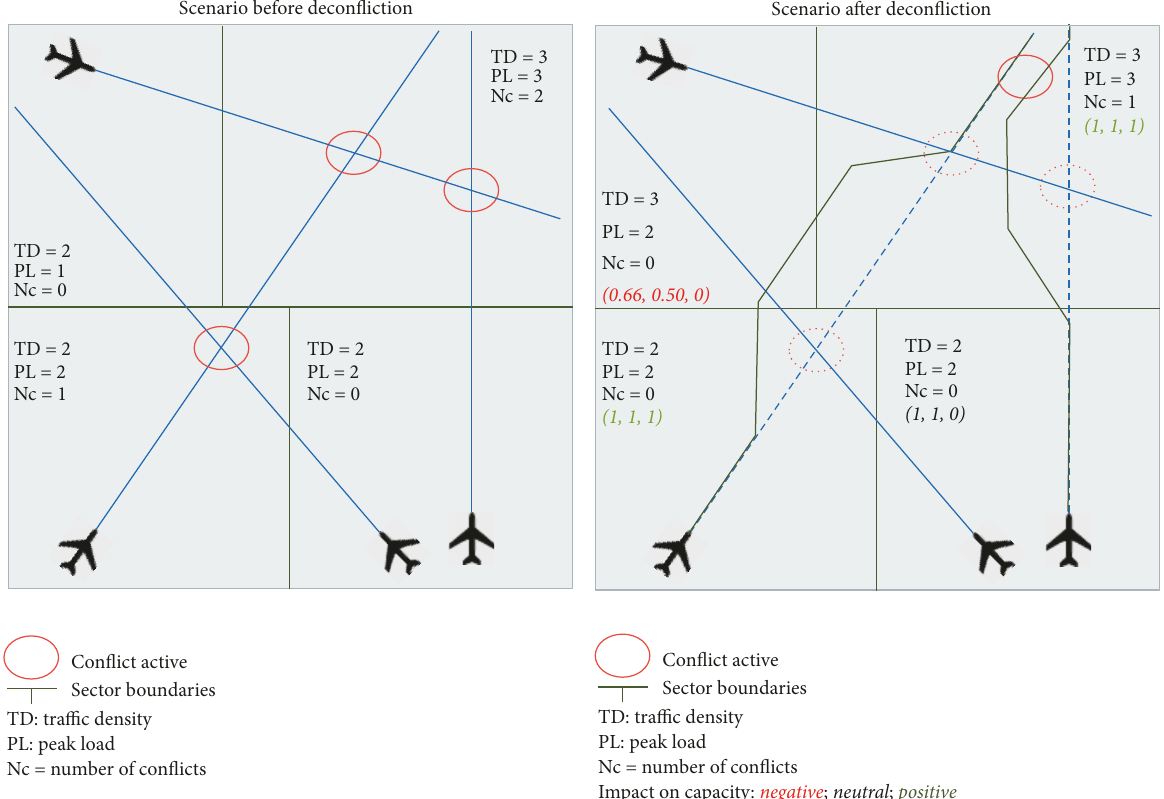
Figure 1: Notional illustration of the application of the impact on capacity metric. Dotted circle means “conflict solved.” (3) ( KPI 𝑆 td , up / KPI 𝑆 td , dc ≤ 1, KPI 𝑆 pl , up / KPI 𝑆 pl , dc ≤ 1, 𝑁 𝑆 𝑐, up − ≤ 0) : increase of ATC workload (less capacity 𝑁 𝑆 𝑐, dc available is